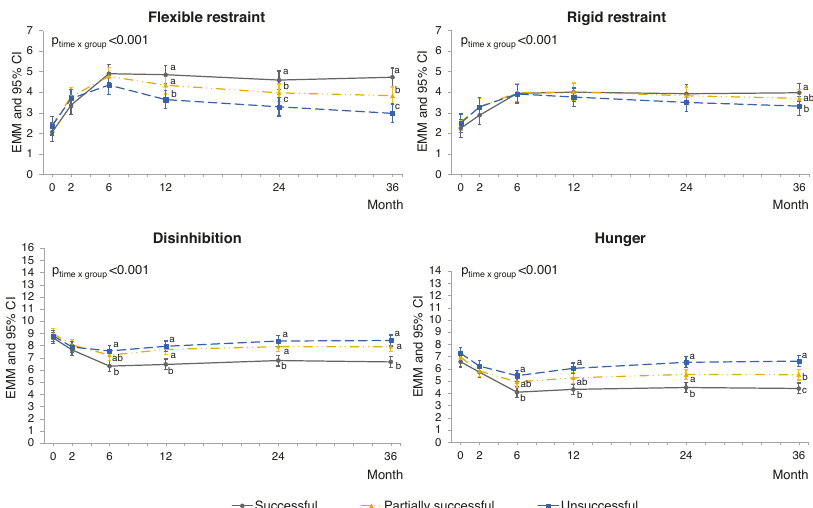
Fig. 2 Estimated marginal means (EMM) and 95% con fi dence intervals (CI) of eating behaviors throughout the PREVIEW intervention by 3-year weight reduction success groups (successful weight reduction = weight loss from baseline to end of study >8% of baseline weight, n = 293; partially successful weight reduction = weight loss 1 – 8%, n = 405; unsuccessful weight reduction = weight loss <1%, n = 264). Determined using linear mixed effects models with maximum likelihood estimation adjusted for age, sex, diet (high vs medium protein), and baseline (month 0) BMI as fi xed effects and participant ID and intervention center as random effects, including group*time interaction term. Pairwise comparisons were conducted at each time point, and signi fi cantly different ( p < 0.05, Bonferroni adjusted) mean values are indicated with different